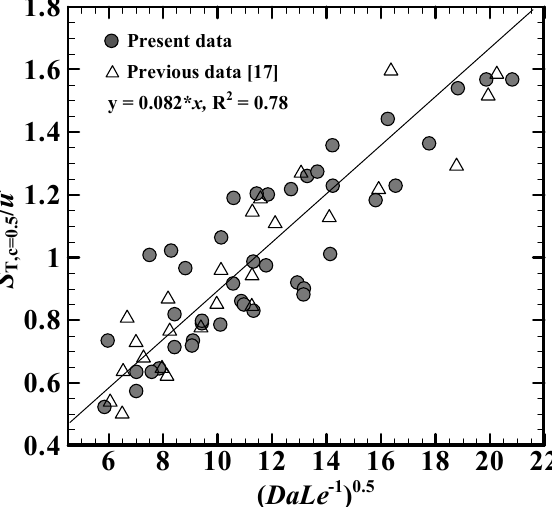
Figure 10. Comparison of present data with previous data obtained by Lawes et al. [17] using Equation (4) for the same iso-octane/air mixtures.